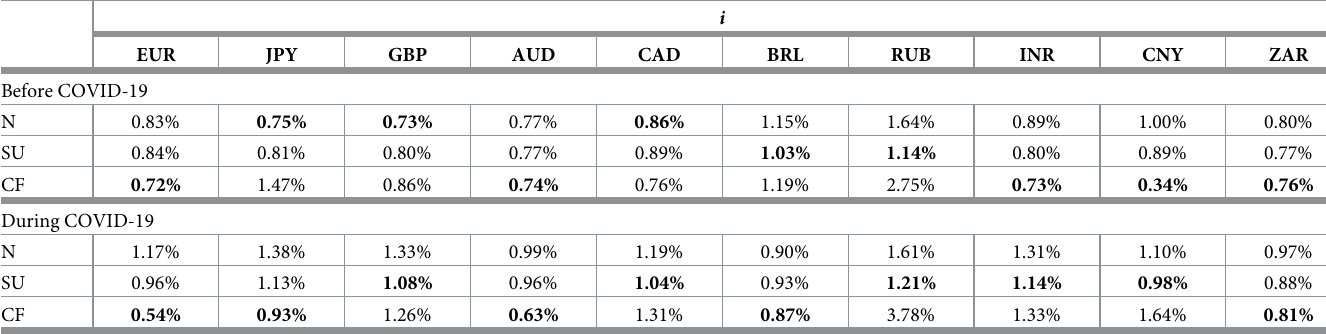
of the forecasted VaR 5 % i